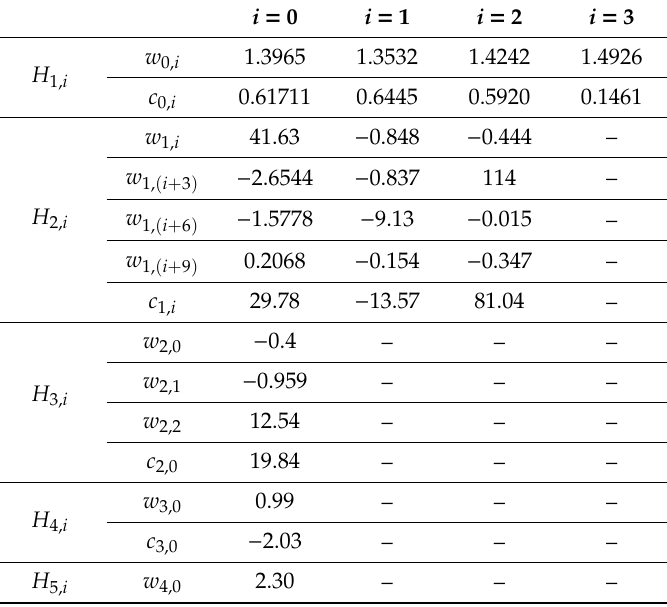
Figure 2. Architecture of the artificial neural network used to estimate the void fraction d.